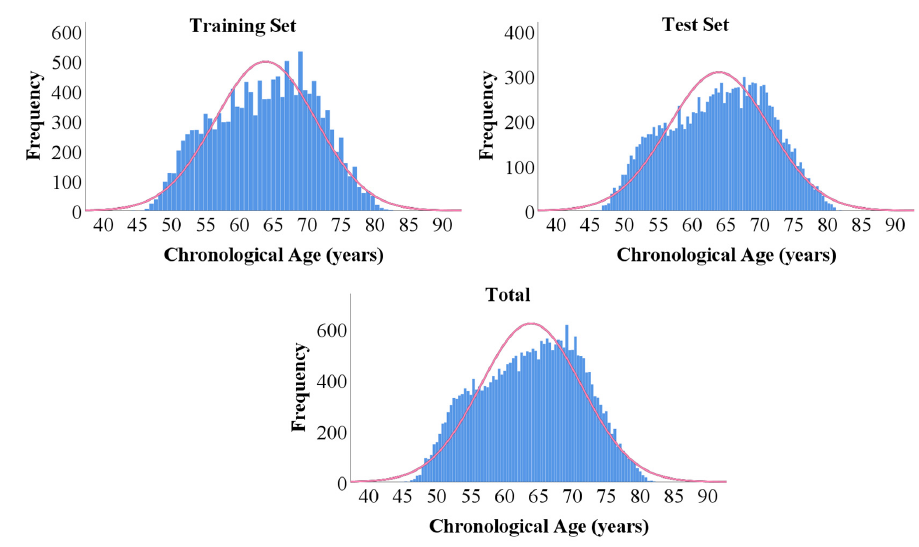
Figure 2. The distributions of chronological ages of the training, test sets, and whole cohort.